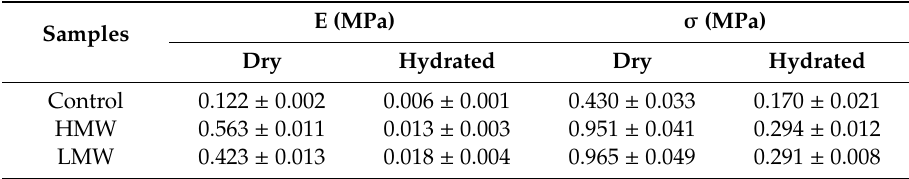
Table 4. Elastic modulus ( E ) and compression strength of control sca ff olds and sca ff olds with HMW and LMW chitosan.